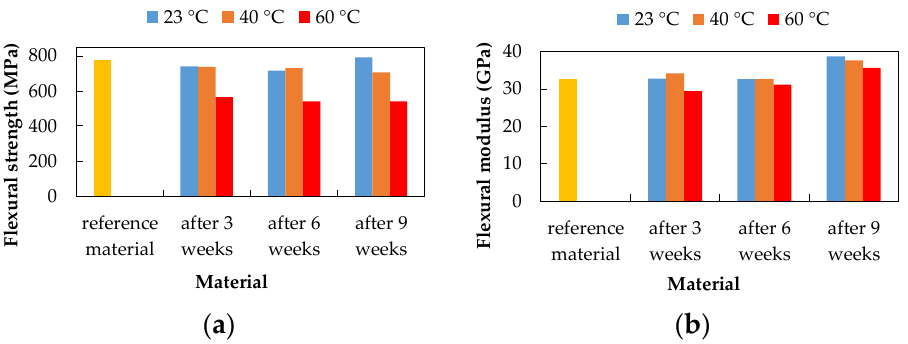
Figure 8. Influence of exposure to 20% NaCl at different temperatures on the CFRP composite; ( a ) flexural strength; ( b ) flexural modulus.